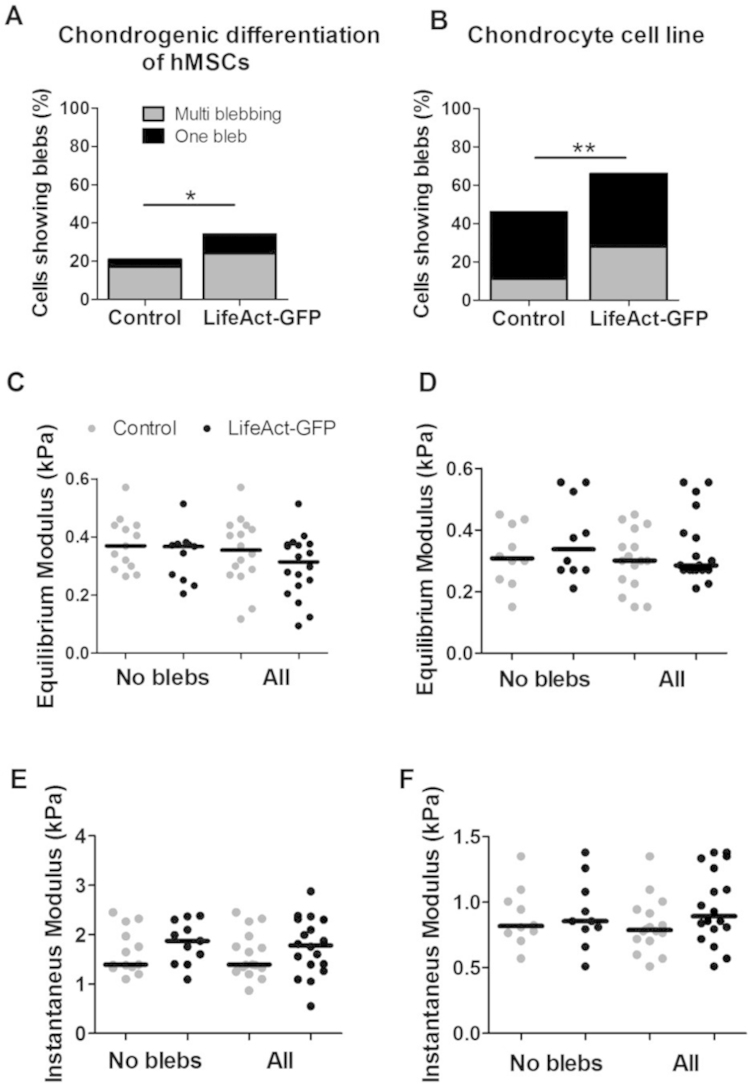
LifeAct-GFP influences membrane blebbing but has no effect on cellular/actin mechanical properties independent of blebbing. Data shown for chondrogenically differentiated hMSCs (A, C and E) and a murine chondrocyte cell line (B, D and F). Histograms showing a significant increase in the percentage of cells exhibiting membrane blebs in cells expressing LifeAct-GFP versus non transfected control cells (A and B; Chi-squared test, *: p<0.05, **: p<0.001). There were no statistically significant differences between LifeAct-GFP transfected and control cells in terms of the equilibrium modulus (C and D) and the instantaneous modulus (E and F) either for the non blebbing cell fraction or for the entire sample population; Mann–Whitney U test. For non blebbing differentiated hMSCs n=13 (control), n=11 (LifeAct-GFP); chondrocyte cell line n=10 (control) and n=10 (LifeAct-GFP). See Table 1 for n values for all cells.